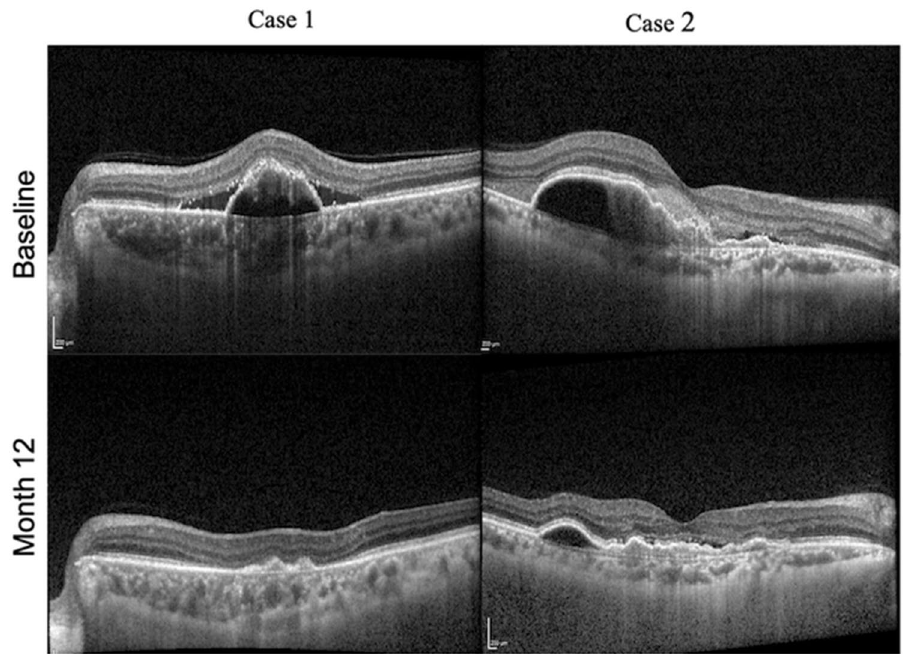
Figure 3. OCT images from 2 eyes showing the change in PED from baseline to month 12. Case 1: Baseline OCT scan showing a large PED with subretinal fluid constituting most of the CRT (367 µm) with PED volume of 0.81 nl and maximum PED height of 338 µm. Month 12 OCT scan showing resolution of PED and subretinal fluid with reduction in CRT (165 ), PED height (67 µm) and PED volume (0.1 nl). Case 2: Baseline OCT scan showing a large sub-foveal PED with SRHM occupying most of the CRT(446 µm) with PED volume of 2.1 nl and maximum PED height of 362 µm) Month 12 OCT scan showing reduction in CRT (220 µm), PED height (171 µm) and PED volume (0.88 nl) along with resolution of SRHM.